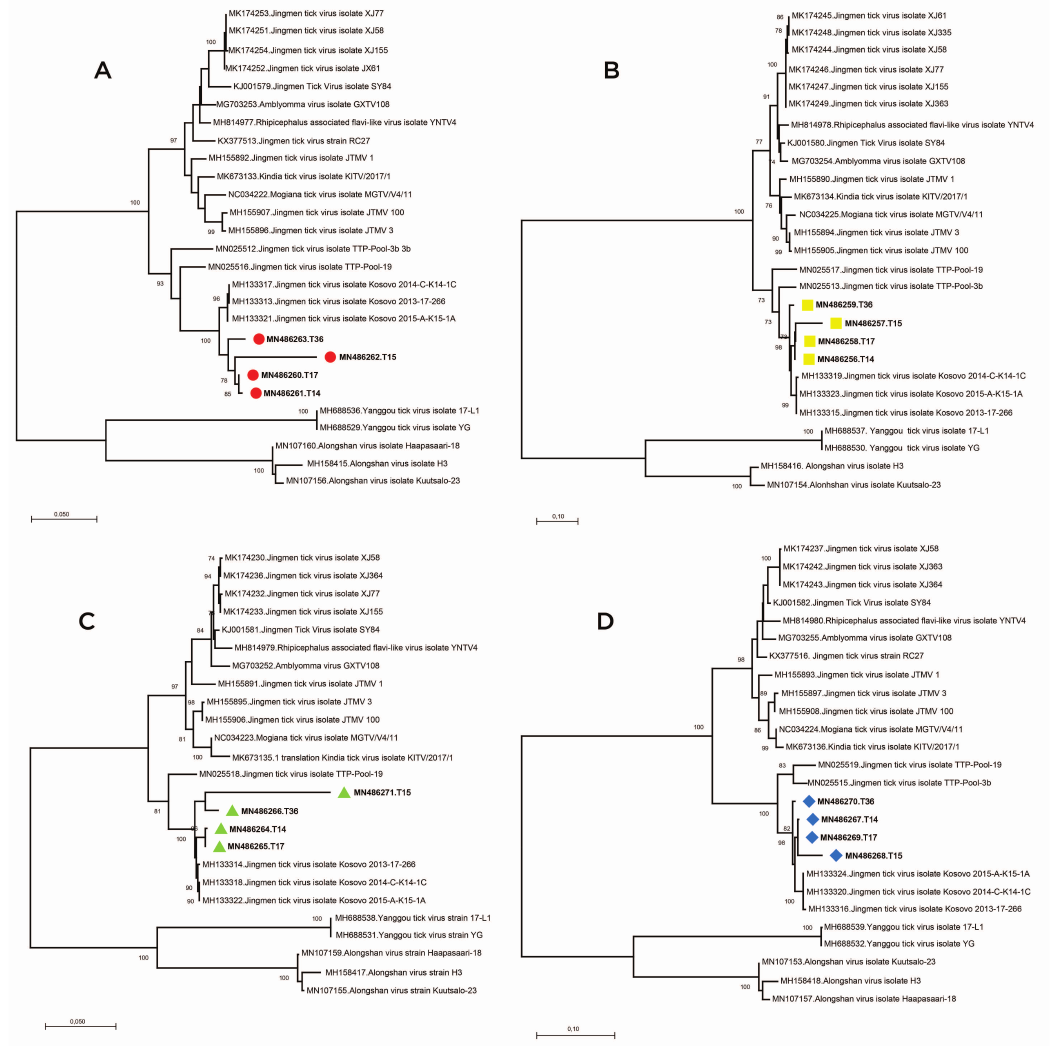
Figure 3. The maximum likelihood analysis of the JMTV complete coding sequences (( A ): segment 1, ( B ): segment 2, ( C ): segment 3, ( D ): segment 4). The tree is constructed using the general time reversible (GTR) model, gamma distributed with invariant sites (G + I) for 500 replications. The sequences characterized in this study are given in bold and indicated with red circles (segment 1), yellow squares (segment 2), green triangles (segment 3) or blue diamonds (segments 4), GenBank accession number and specimen codes. Global virus strains are indicated by GenBank accession number, virus and strain / isolate name. Bootstrap values higher than 70 are